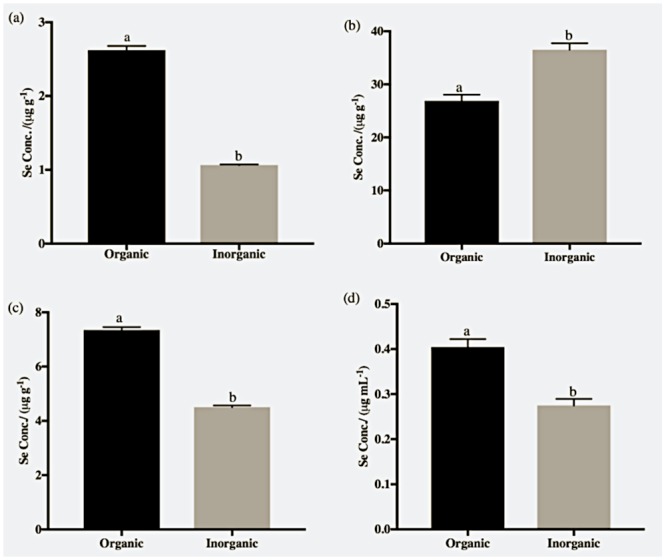
Selenium concertation (μg g-1 of dry weight) in (a) fillets, (b) livers, (c) kidneys and (d) plasma of Nile tilapia, Oreochromis niloticus, supplemented with seleno-L-methionine (organic) and sodium selenite (inorganic) in basal diet.Means with different letters were significantly different (p<0.05). Data is represented as mean ± Standard Errors, n = 6.